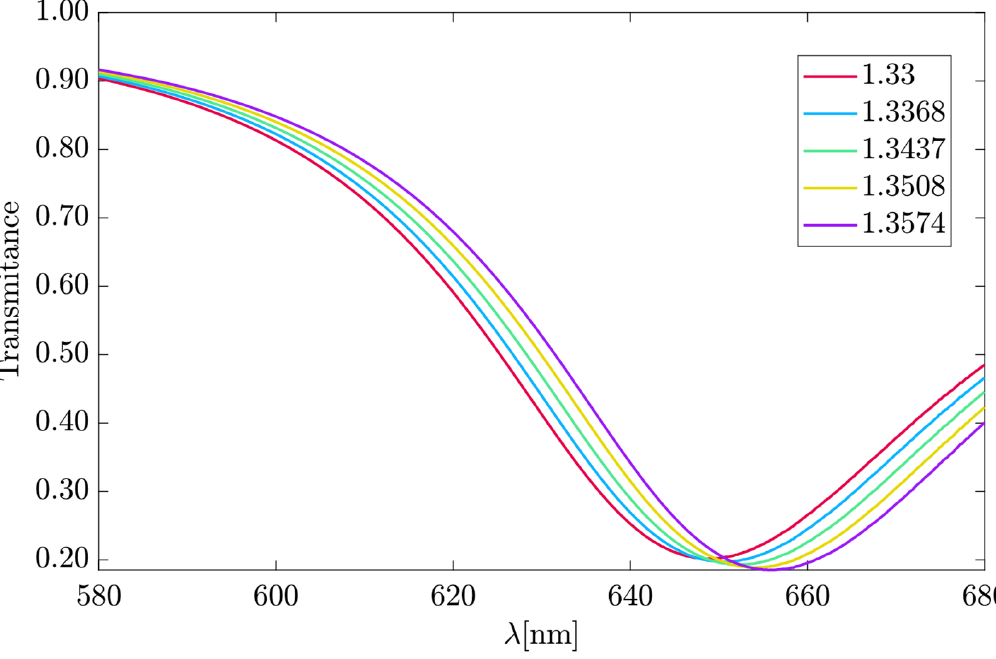
Figure 13. The transmittance spectrum of the LRSPP hybrid mode.